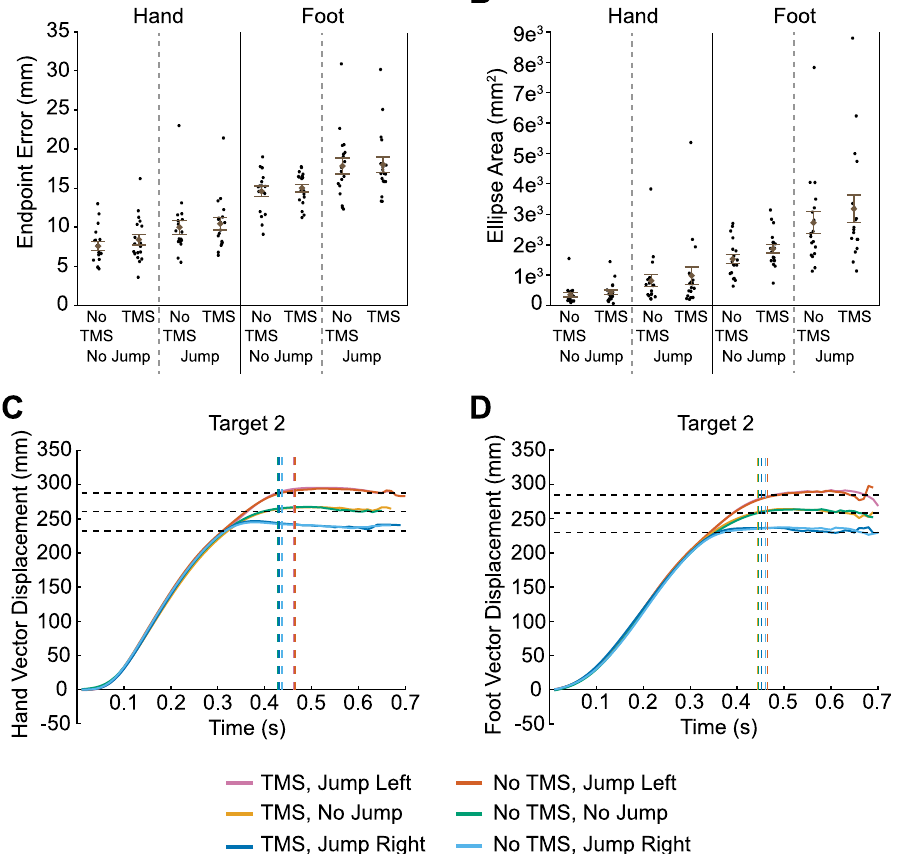
Fig 5. Results of transcranial magnetic stimulation (TMS) to aPreC. Euclidean endpoint error (A) and ellipse area based on endpoint error (B) for hand and foot reaches across all conditions. Filled circles represent mean data from each individual participant. Group mean ± SE is also shown. Hand (C) and foot (D) trajectories towards target two are shown for each condition. Horizontal dashed lines represent the final position of the target (jump left, no jump, and jump right). Vertical dashed lines indicate the average time at which the finger or toe contacted the touchscreen for each condition.